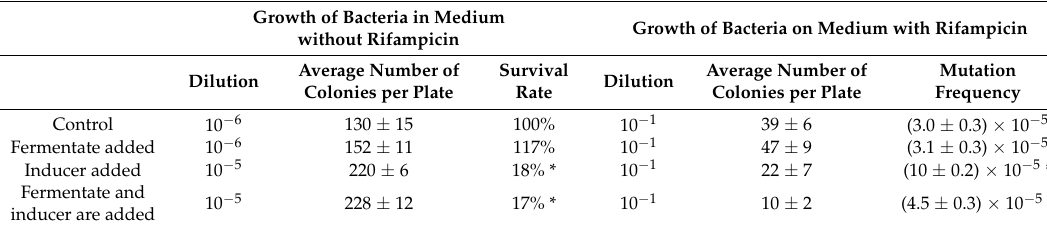
Growth of Bacteria on Medium with Rifampicin